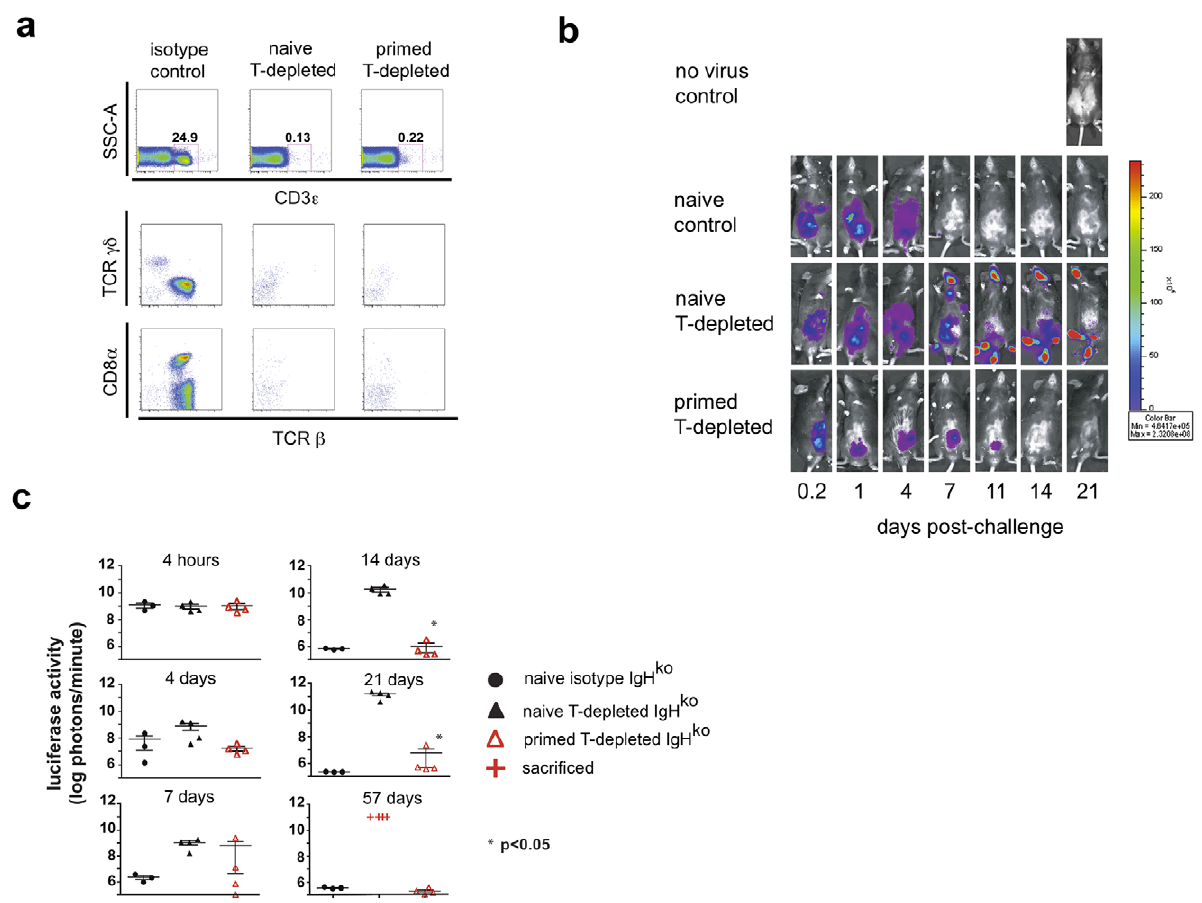
Figure 1. A primed innate cell population provides protection against a challenge with recombinant vaccinia virus. Six months after intraperitoneal (ip) inoculation with vaccinia virus (primed) or PBS (naı¨ve), IgH ko mice were treated with T cell-depleting or isotype control antibody mixtures and 10 days later were challenged with 2 6 10 6 pfu rVV-luc intraperitoneally ( ip ). Isotype control or depleting monoclonal antibodies were administered ip every 2 weeks starting a week to ten days prior to viral challenge. (a) Flow cytometric plots of CD3 staining of peripheral blood cells from naı¨ve control, naı¨ve T-depleted, or primed T-depleted mice that fall within the lymphocyte gate are shown, including the percentage of total cells within the CD3 + gate at 1 week post-challenge. The TCR b , TCR cd , and CD8 a staining profiles of the cells that fall within the CD3 + gate are also shown. ( b ) IVIS images of representative mice from the naı¨ve control, naı¨ve T cell-depleted, and primed T cell-depleted groups following the challenge with rVV-luc are shown. ( c ) The measurements of rVV-luc viral loads in each group over time are shown with relative viral loads based on the number of photons emitted normalized for a one minute exposure. The measurement for each individual mouse is plotted, and the center line indicates the mean with error bars representing the SEM. Statistical significance between T-depleted groups was assessed by t-tests using Mann- Whitney analysis and is indicated by the asterisk (p , 0.05). Results are representative of 4 independent experiments.